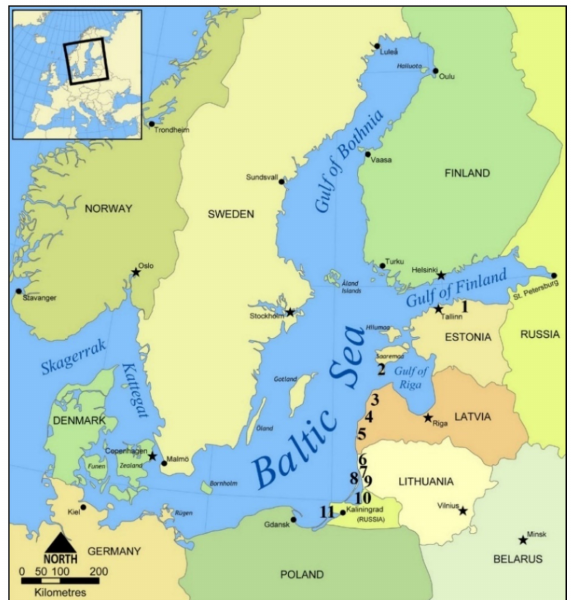
Figure 1. Map of the Baltic Sea with the re-analysis case study sites in Estonia, Latvia, Lithuania, and Kaliningrad Oblast of the Russian Federation (Map source: